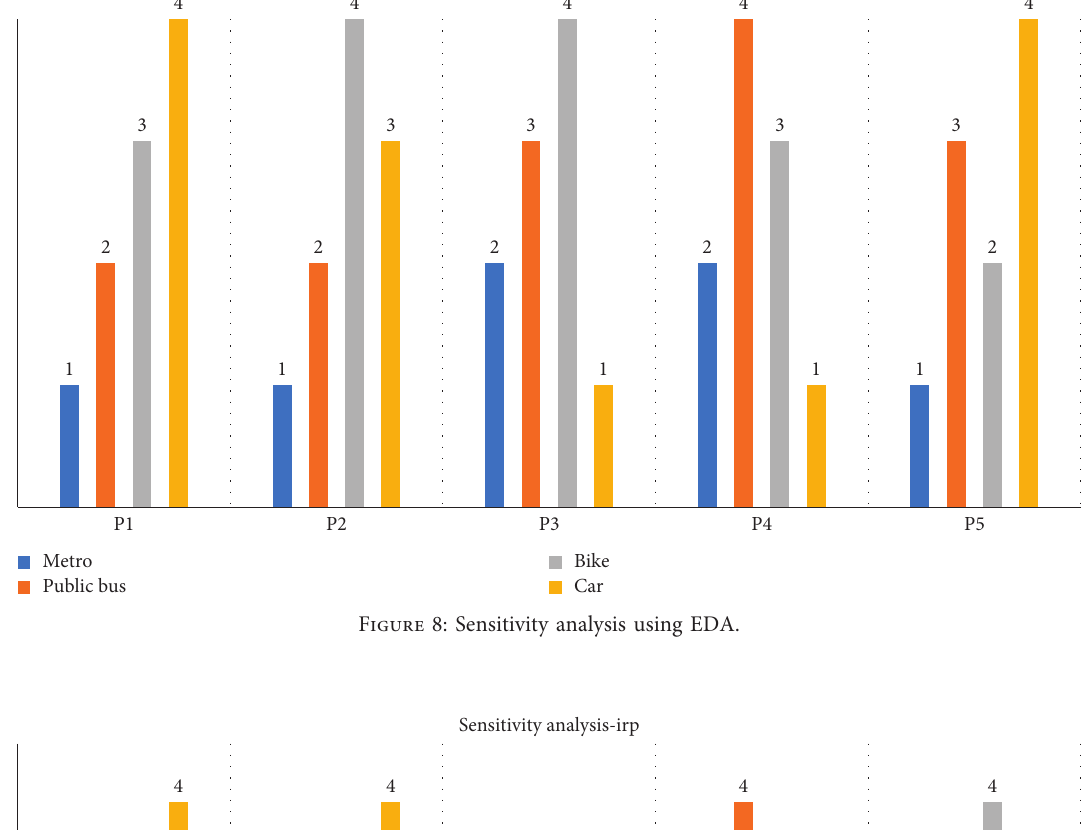
Figure 8: Sensitivity analysis using EDA.